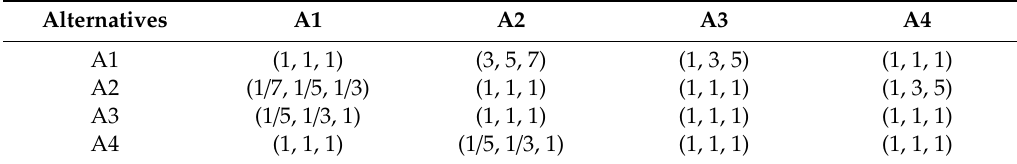
Table 15. Evaluation with respect to the exploitation time.